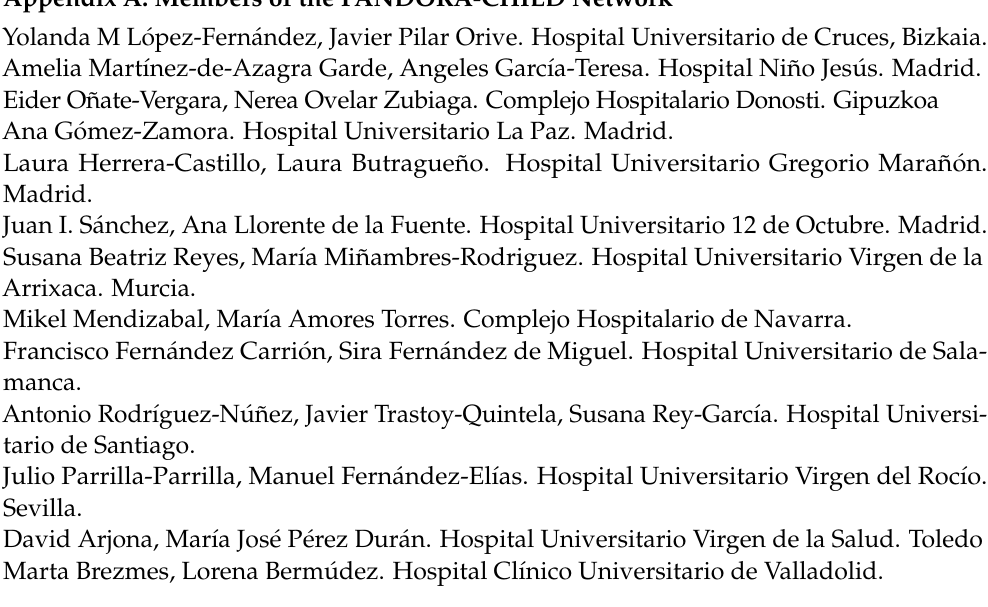
Table S2: Ancillary treatments for the total